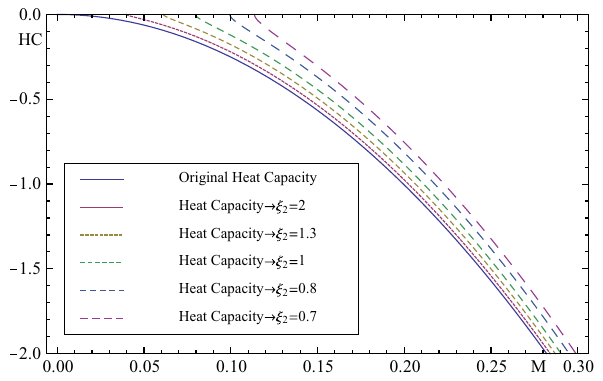
Fig. 1 The LIV-DR induced black hole heat capacity versus its mass, where L p = k B = 1